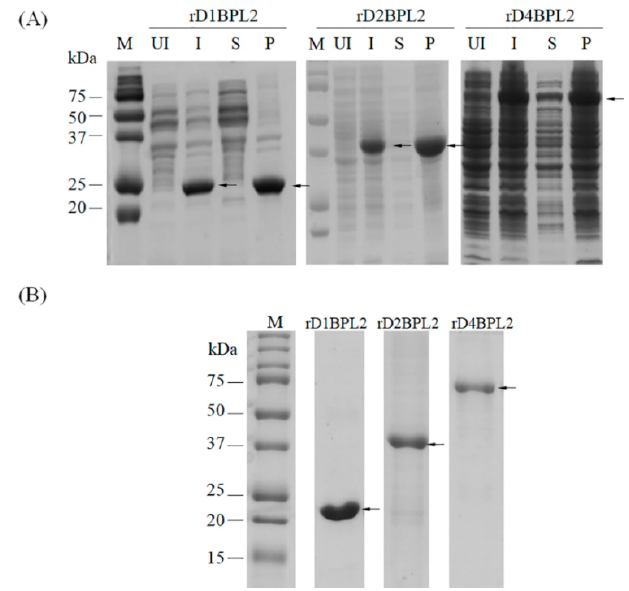
Figure 5. Solubility analysis and purification of recombinant lectins by Ni ‐ NTA agarose chromatography. ( A ) Solubility of recombinant proteins. UI, total protein of the un ‐ induced cell fraction; I, induced; S, soluble in PBS; P, pellet. Arrows indicate target proteins. ( B ) Purified recombinant lectins. M, molecular weight marker. Arrows indicate purified recombinant proteins.